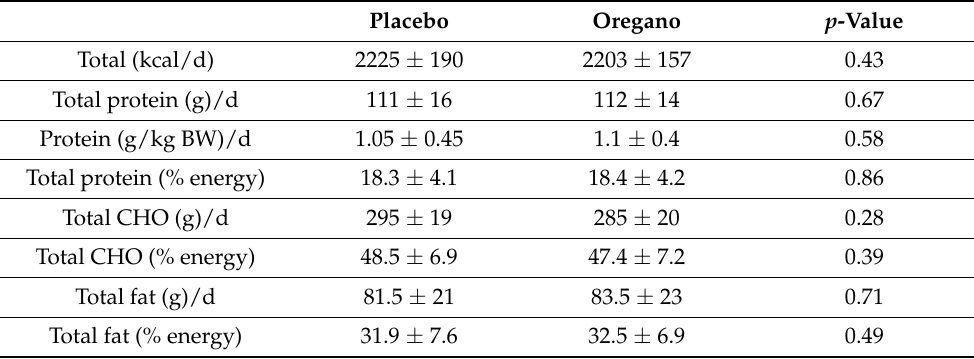
Table 2. Analysis of nutrient supplements (mean ± SD).